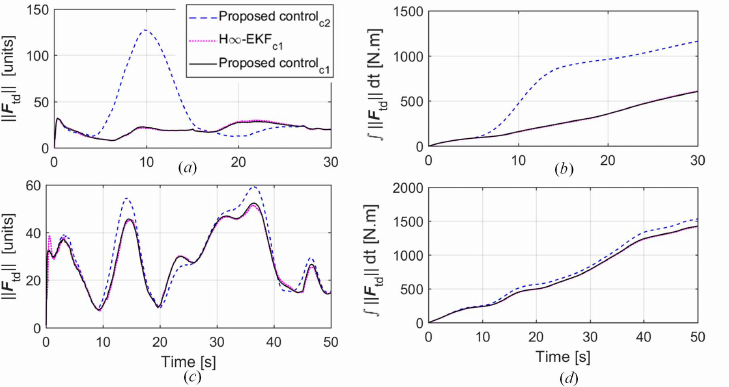
Figure 9. Time histories of the norm of the vector F td and UVMS energy consumption. ( a , b ) Results from the linear trajectory tracking, ( c , d ) results from the circular trajectory tracking, ( F td ; i.e., the vector of thruster forces and actuator